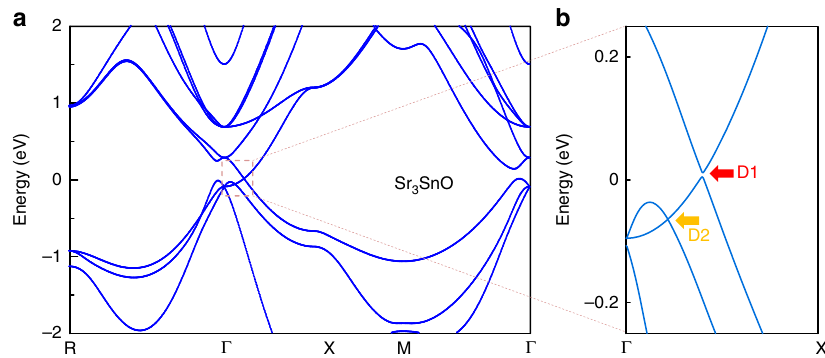
Fig. 2 Antiperovskite electronic band structures. a Band diagram of Sr 3 SnO obtained from fi rst-principles calculations. b The enlarged band diagrams near Dirac nodes. The large arrows indicate the location of